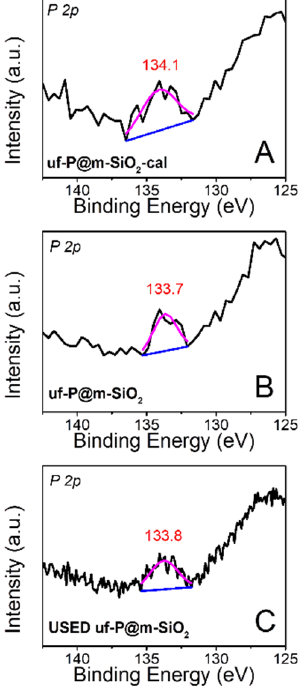
of P. The peak is located at ~134 eV for all samples, which can be attributed to the presence